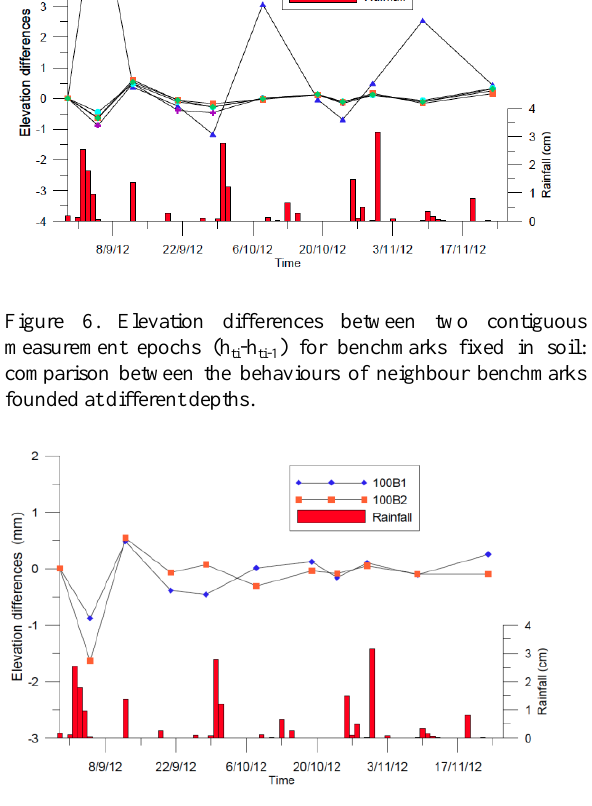
Figure 7. Elevation differences between two contiguous measurement epochs (h ti -h ti-1 ) for benchmarks fixed in soil at 1m depths.